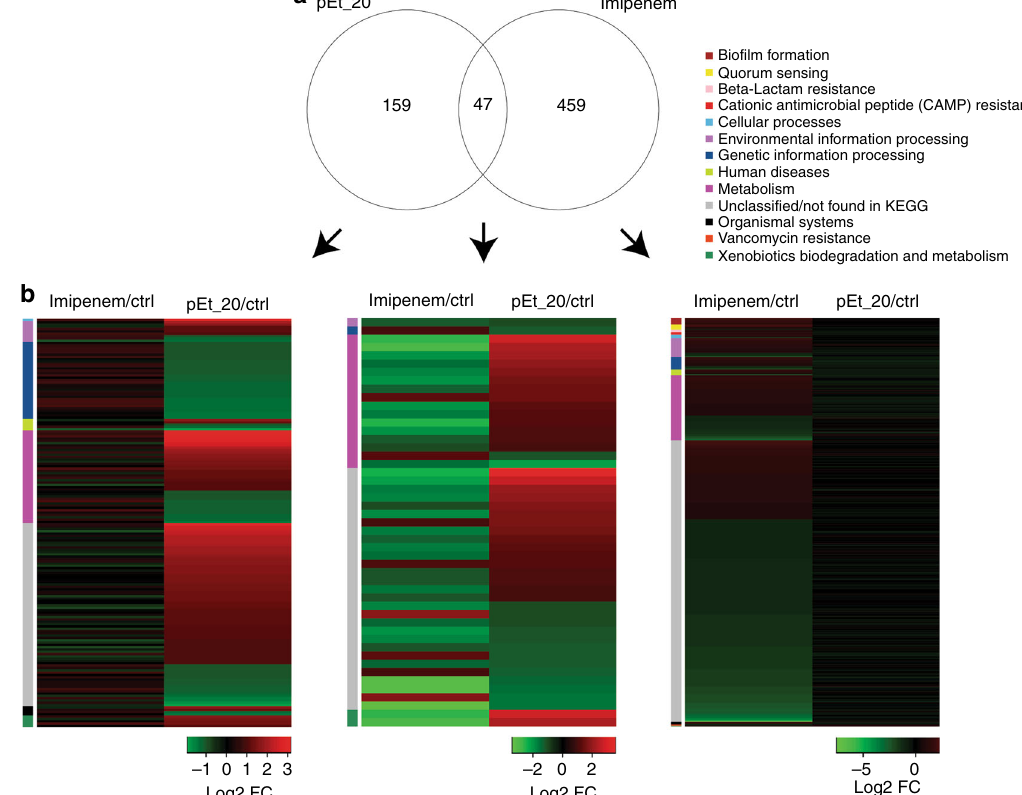
Fig. 5 RNA-seq analysis of bacterial resistance. MDR A . baumannii 10073 was treated with imipenem or pEt_20 for 30 passages at 0.5× MIC that was measured at each passage (treatment duration of each passage: 18 h). a A Venn diagram depicting the overlap of differentially regulated genes either upon pEt_20 or imipenem treatment, relative to untreated controls. The numbers inside the Venn diagram (from left to right) represent the number of differentially regulated genes: found only in pEt_20 treatment (left), common to both groups (venn diagram intersection), only in imipenem treatment (right), respectively. b The three independent heat maps depict genes from the corresponding groups in a (as indicated by the respective black arrows). The heat map on the left shows expression data for genes that are only signi fi cant in pEt_20 treatment but were shown in conjunction with the expression data from imipenem treatment (not differentially regulated, i.e., Log 2 -fold change in the range between − 1 and + 1). The heat map in the center depicts signi fi cant genes that are shared by both treatment groups. The heat map on the right shows genes that are only signi fi cant in imipenem treatment along with Log 2 -fold change from pEt_20 treatment (not differentially regulated but shown for comparison). The row color side bars on all three heat maps represent the KEGG categories that the genes